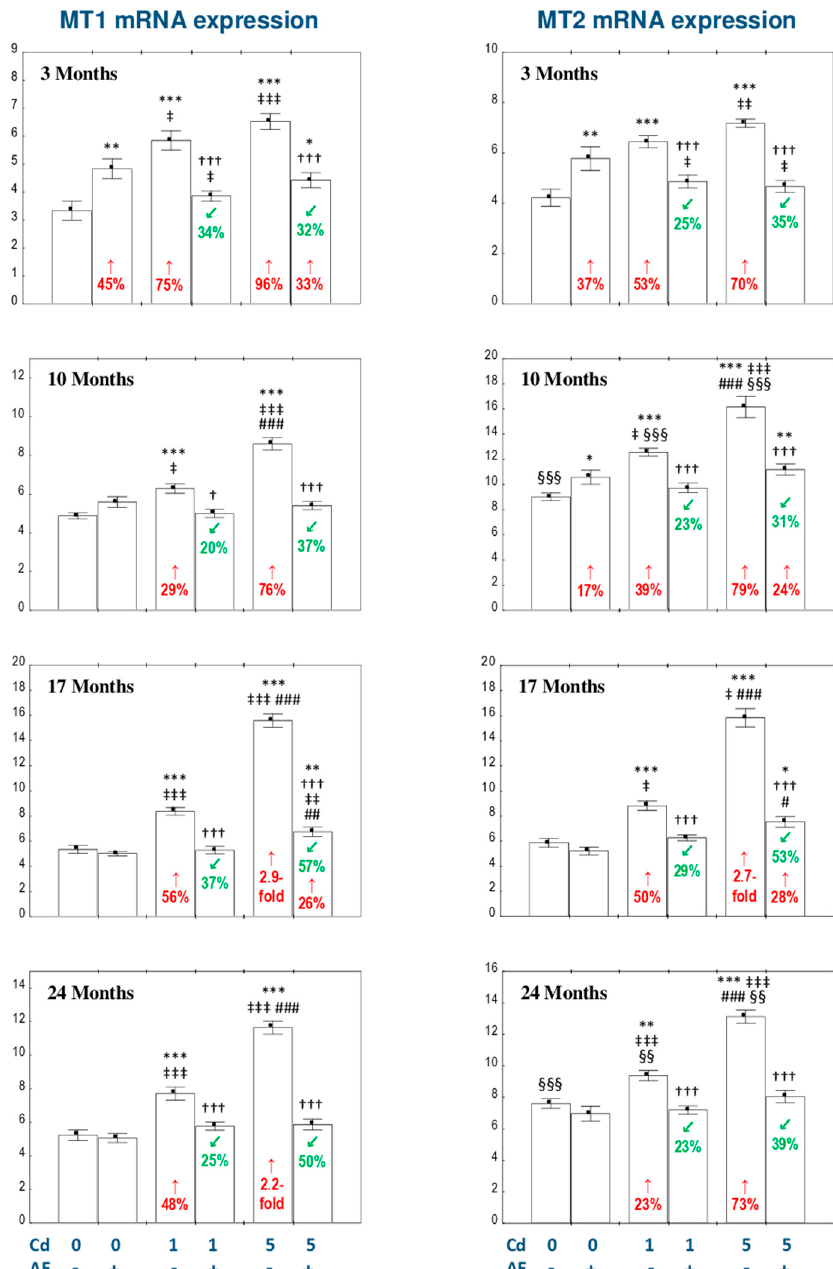
Figure 4. The influence of the extract from Aronia melanocarpa L. berries (AE) on the expression of metallothionein 1 (MT1) and metallothionein 2 (MT2) messenger ribonucleic acid (mRNA) in the liver of female rats exposed to cadmium (Cd). The females were given Cd in the diet at the concentration of 0, 1, and 5 mg Cd/kg and/or 0.1% aqueous AE (+) or not ( − ). Data are represented as mean ± SE for 8 animals, except for 7 females in the AE, Cd 1 , and Cd 5 groups after 24 months. Statistically significant differences (ANOVA, Duncan’s multiple range post hoc test): * p < 0.05, ** p < 0.01, *** p < 0.001 vs. control group; † p < 0.05, ††† p < 0.001 vs. appropriate group treated with Cd alone; ‡ p < 0.05, ‡‡ p < 0.01, ‡‡‡ p < 0.001 vs. group administered with AE alone; # p < 0.05, ## p < 0.01, ### p < 0.001 vs. appropriate group receiving the 1 mg Cd/kg diet (alone or with AE); §§ p < 0.01, §§§ p < 0.001 vs. MT1 in appropriate experimental group. Numerical values in bars disclose the percentage changes or factors of changes in comparison to the control group ( ↑ , increase) or the appropriate group given Cd alone ( (cid:46) ,